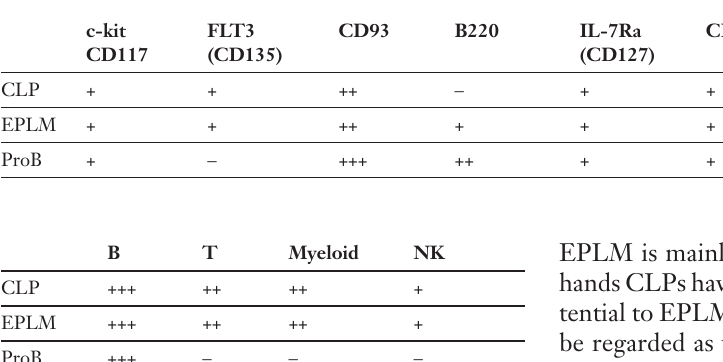
Developmental poten- tial of early lympho- cyte progenitors in the bone